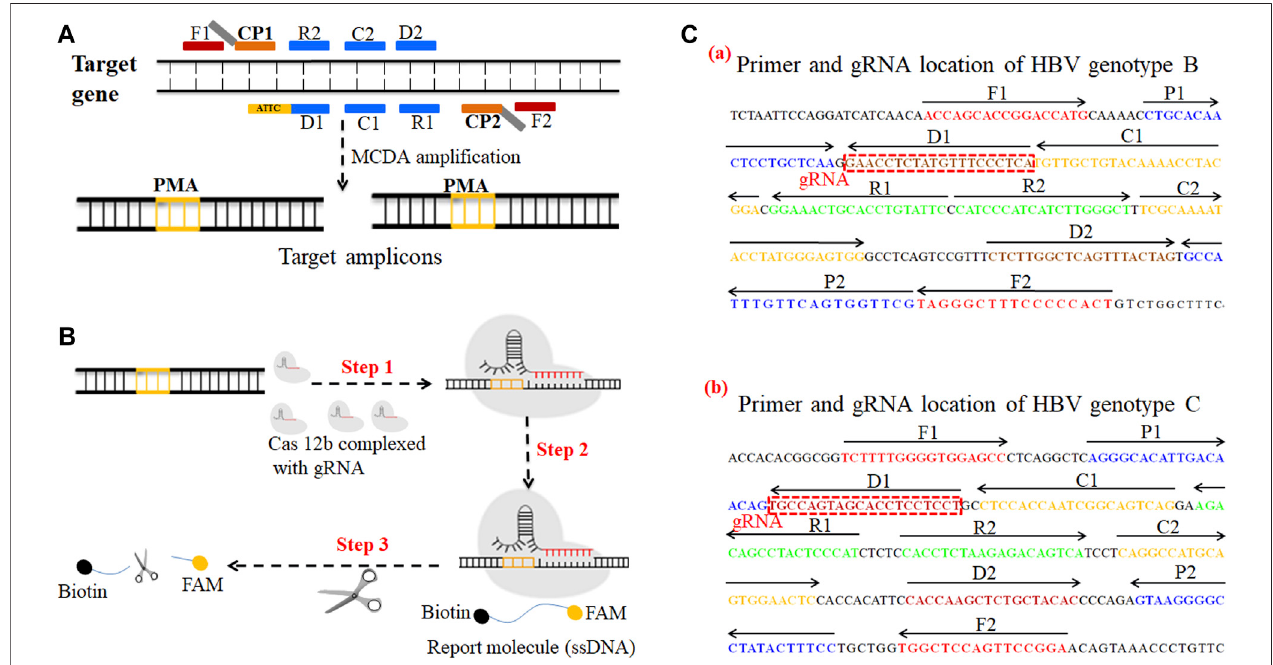
FIGURE 1 | A schematic illustration of the principle of the CRISPR-HBV system. (A) Schematic illustration of the principle of MCDA with the modi fi ed primer. The ampli fi cation primer D1 was modi fi ed with a PAM site (TTC). After ampli fi cation, a CRISPR-Cas12b recognition site was constructed in the target amplicons. (B) Schematic illustration of the CRISPR-Cas12b detection system. Upon recognition of the matching target sequence, the CRISPR-Cas12b complex cleaves a single- stranded DNA reporter molecule. © Sequences and location of the S gene of HBV genotypes B and C used to devise the MCDA primers and gRNAs. The sites of MCDA primers are underlined, and the gRNAs are in boxes. Right arrows and left arrows indicate the sense and complementary sequences which were used in this study,